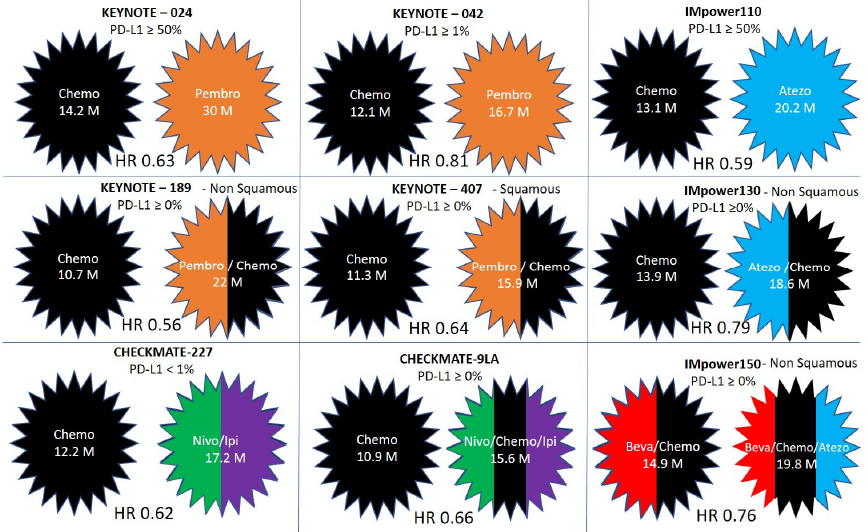
Figure 3. Comparison of over survival and hazard ratios (HR) in clinical trials incorporating immunotherapy in the first line for patients with non-small cell lung cancer. The treatment arms without and with immunotherapy are compared in KEYNOTE-024, KEYNOTE-042, KEYNOTE-189,